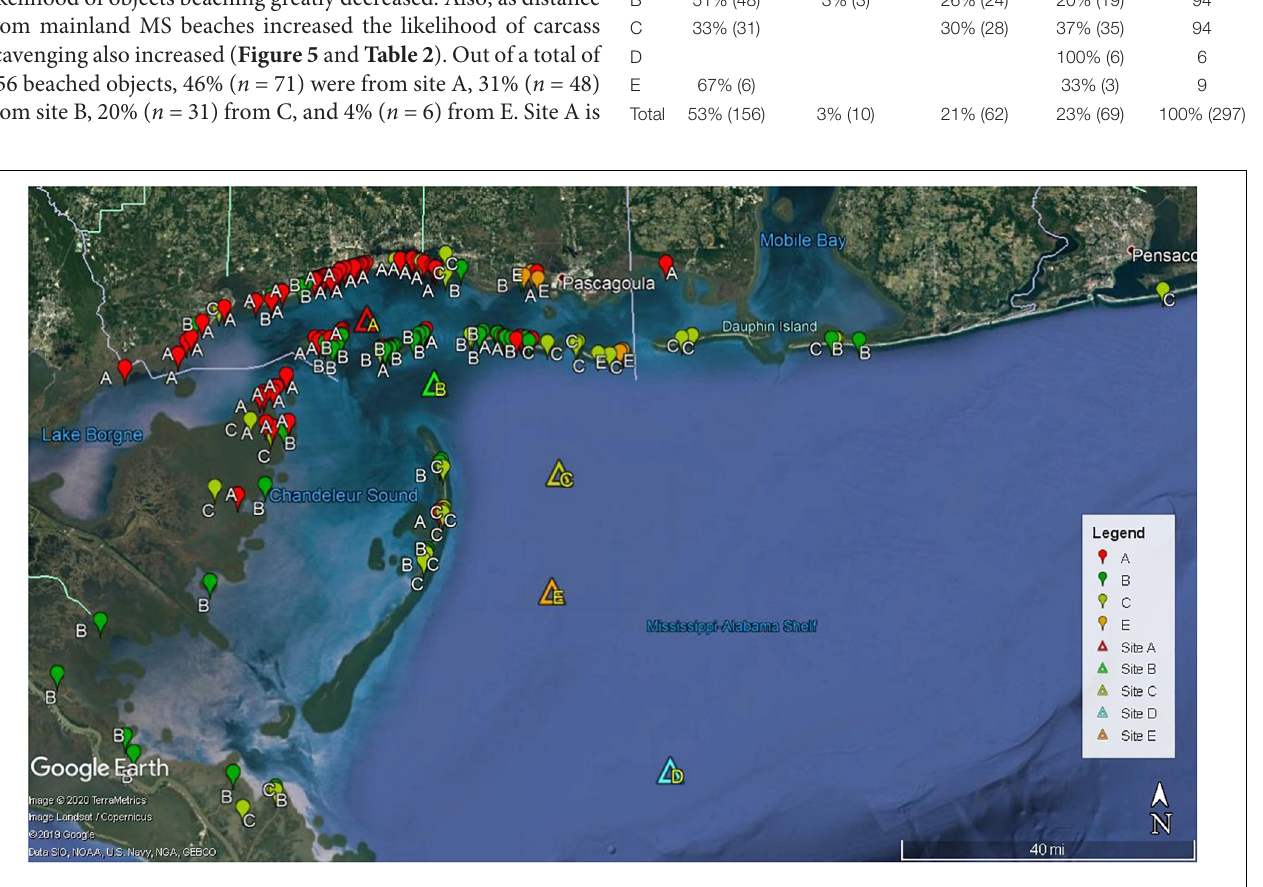
Frontiers in Marine Science |